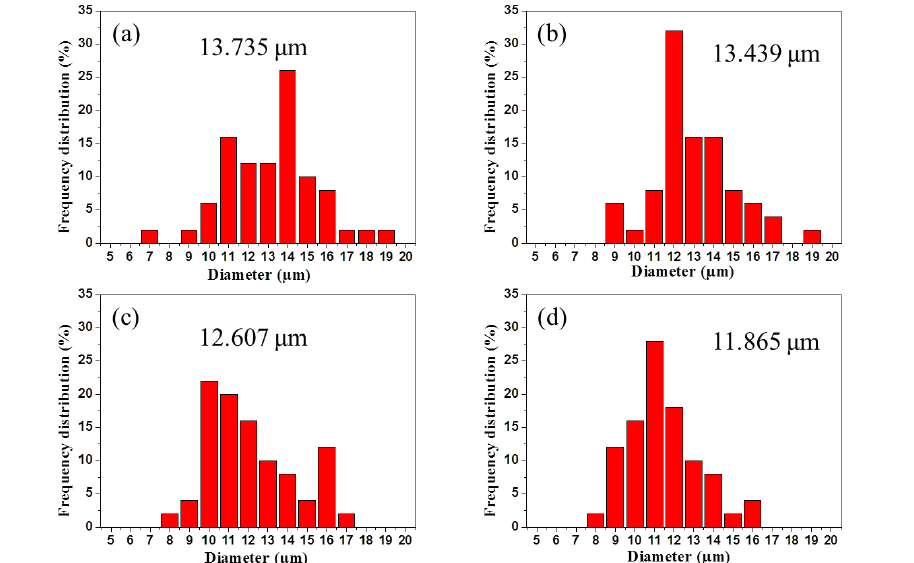
Fig. 6 Diameter distribution of SiC fiber at different heating rates: (a) 10 ℃ /min, (b) 20 ℃ /min, (c) 30 ℃ /min, and (d) 40 ℃ /min. Table 2 Elemental composition of SiC fiber at different heating rates (Unit: at%) Heating rate